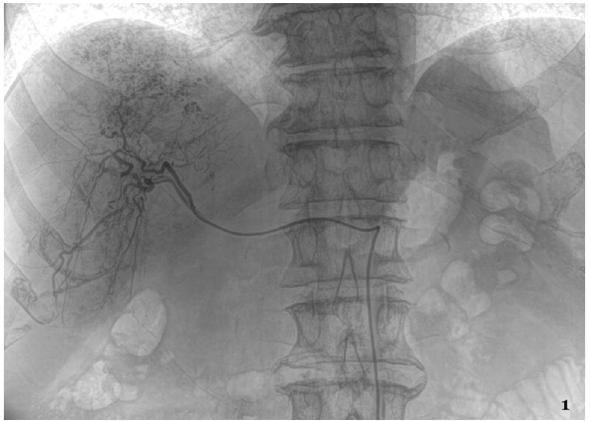
Figure 1. X-ray image. 64 years old male patient with PLC in the RLL during TACE